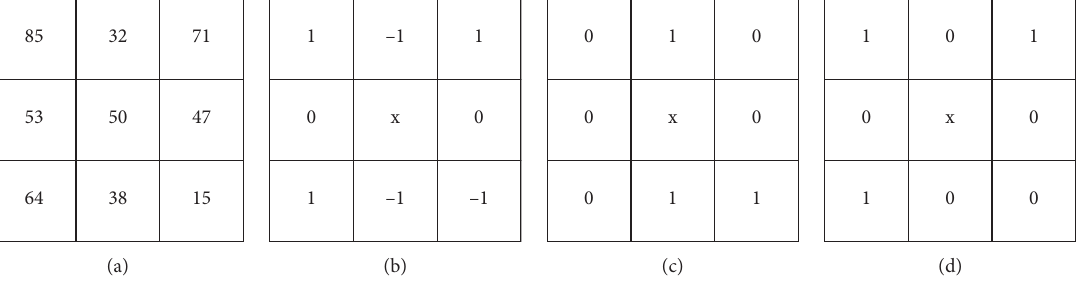
Figure 12: (a–d) LTP code with τ ≥ + 15 , τ ≤ − 15 and both positive and negative LBP codes. Table 2: Works grouped by feature extraction